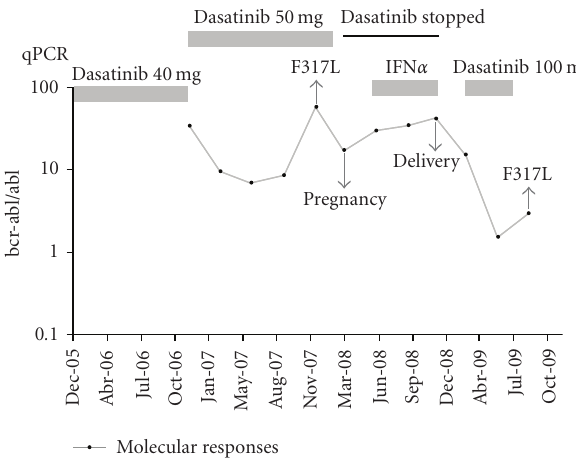
Figure 1: Molecular responses during the entire observation